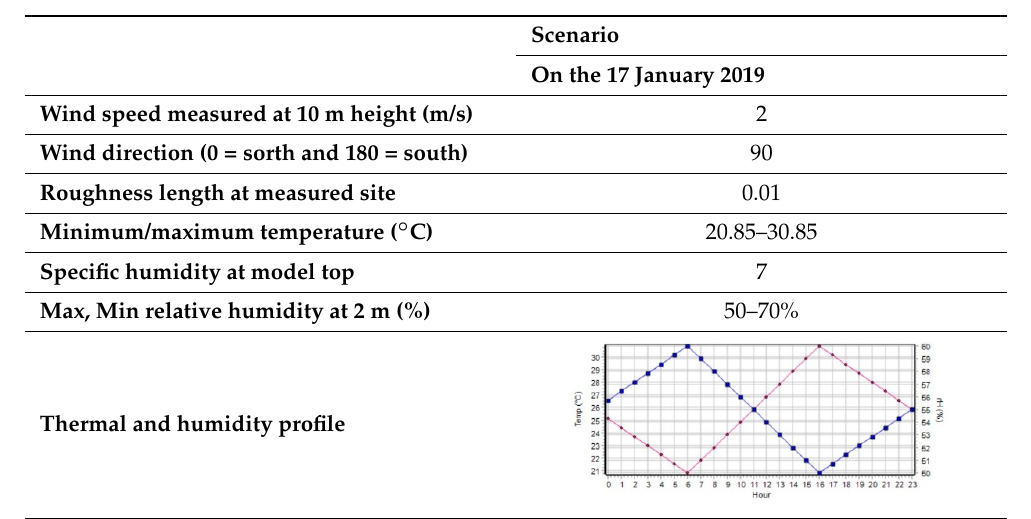
Table 7. Meteorological input for the simulation of scenarios on 17 January